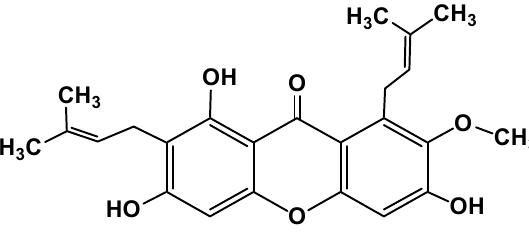
Figure 1. Structure of α -mangostin.